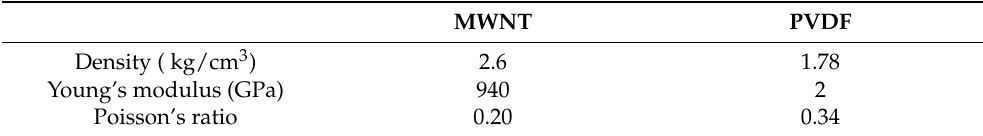
Table 1. Mechanical properties of MWNTs and